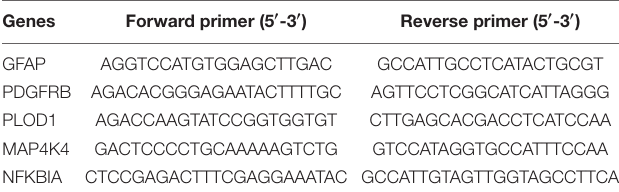
TABLE 2 | Primer sequences for RT-qPCR. Genes